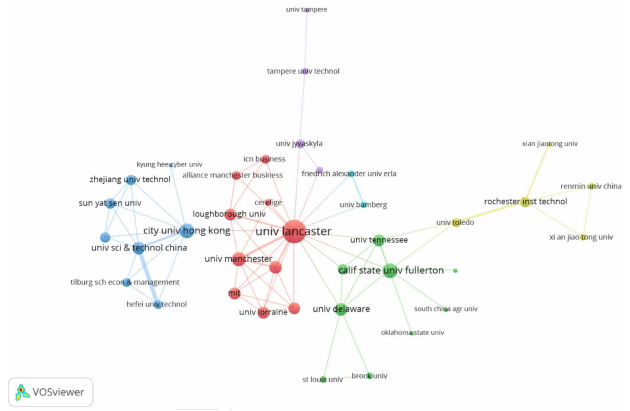
Figure 4. Organization co-authorship graph.